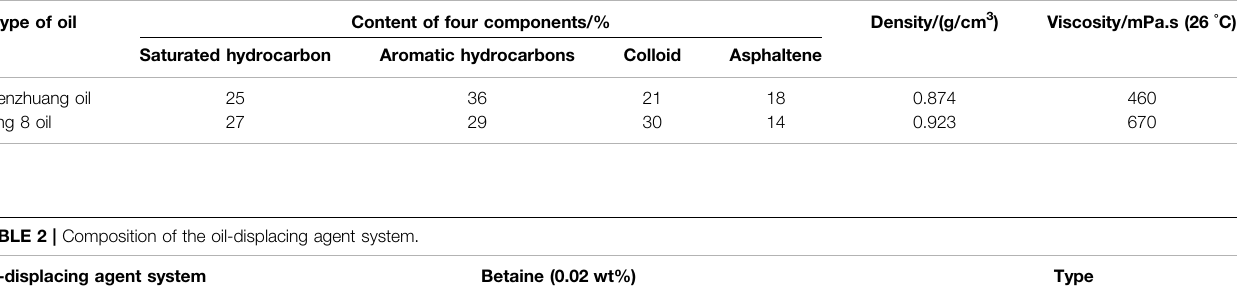
TABLE 1 | Basic properties of crude oil.